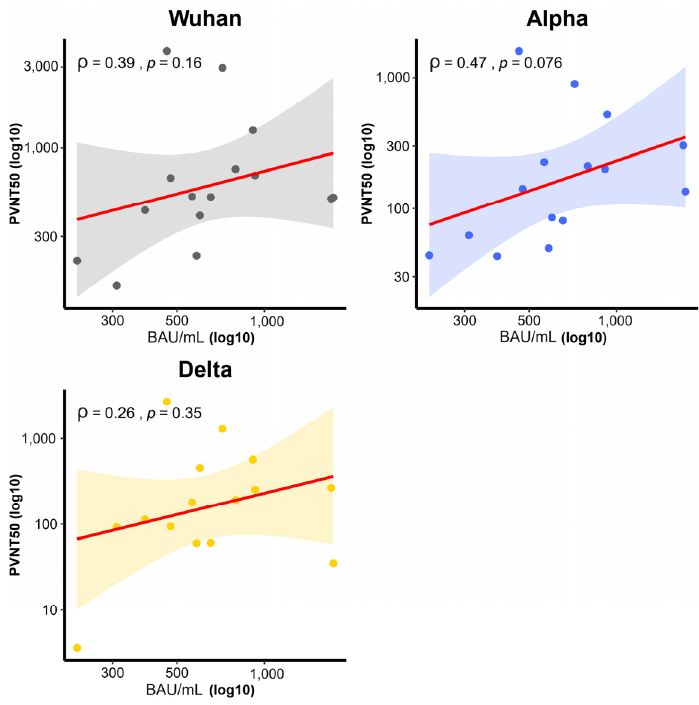
Figure 7. Correlation between PVNT 50 titer with Ab and anti-SRBD level by virus variant group. (Wild-type, Alpha variant, and Delta variant) Correlation (solid line), 95% confidence intervals (curved line) . Wild-type ( ρ = 0.39, p = 0.16), Alpha variant ( ρ = 0.47, p = 0.076), and Delta variant ( ρ = 0.26, p = 0.35). Spearman’s rank correlation coefficient was used to assess the correlation. Serum received a